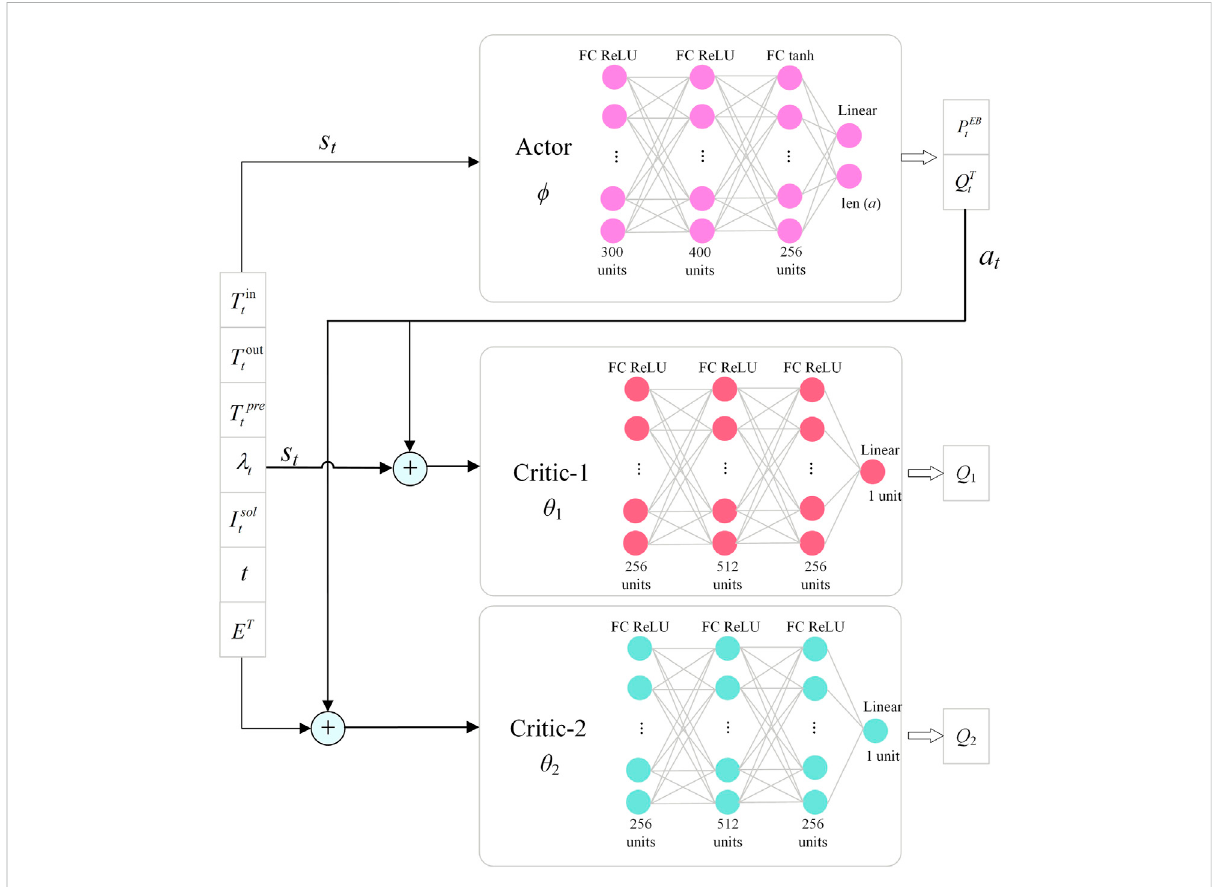
FIGURE 6 Actor and critic network structure.